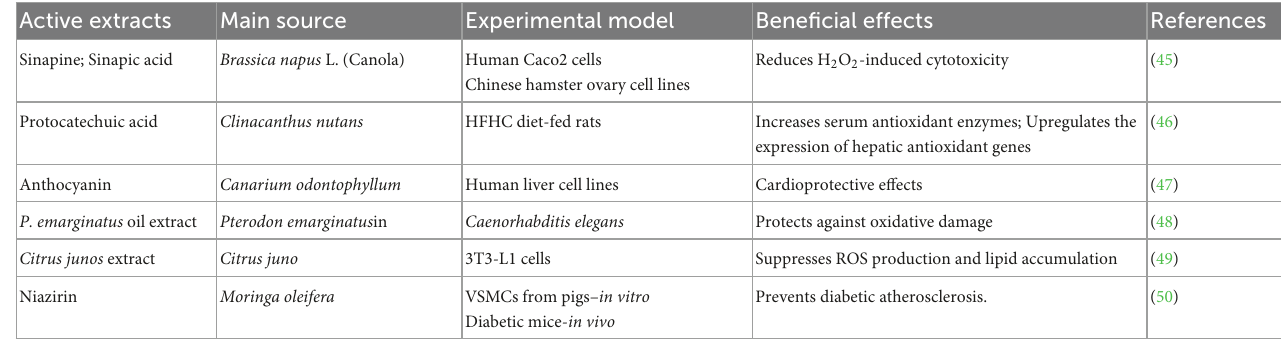
TABLE 3 The effects of crude extracts from natural sources on circadian clock